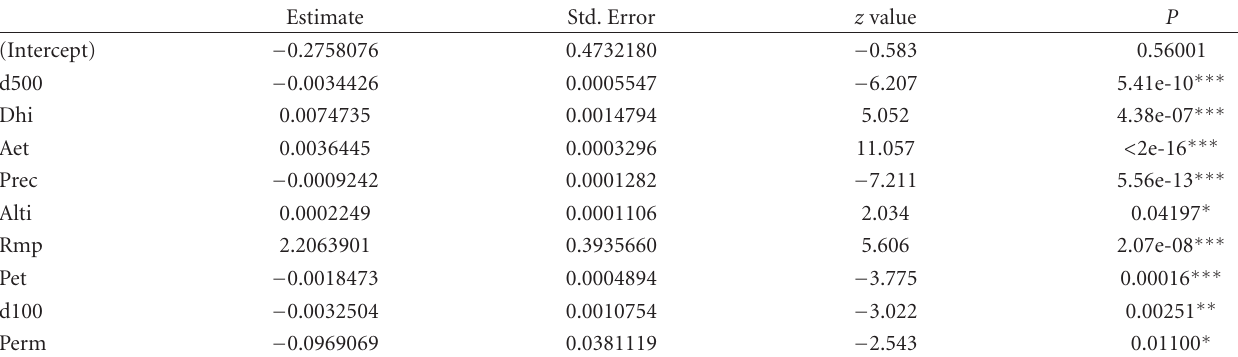
Table 5: B. bufo and B. calamita .